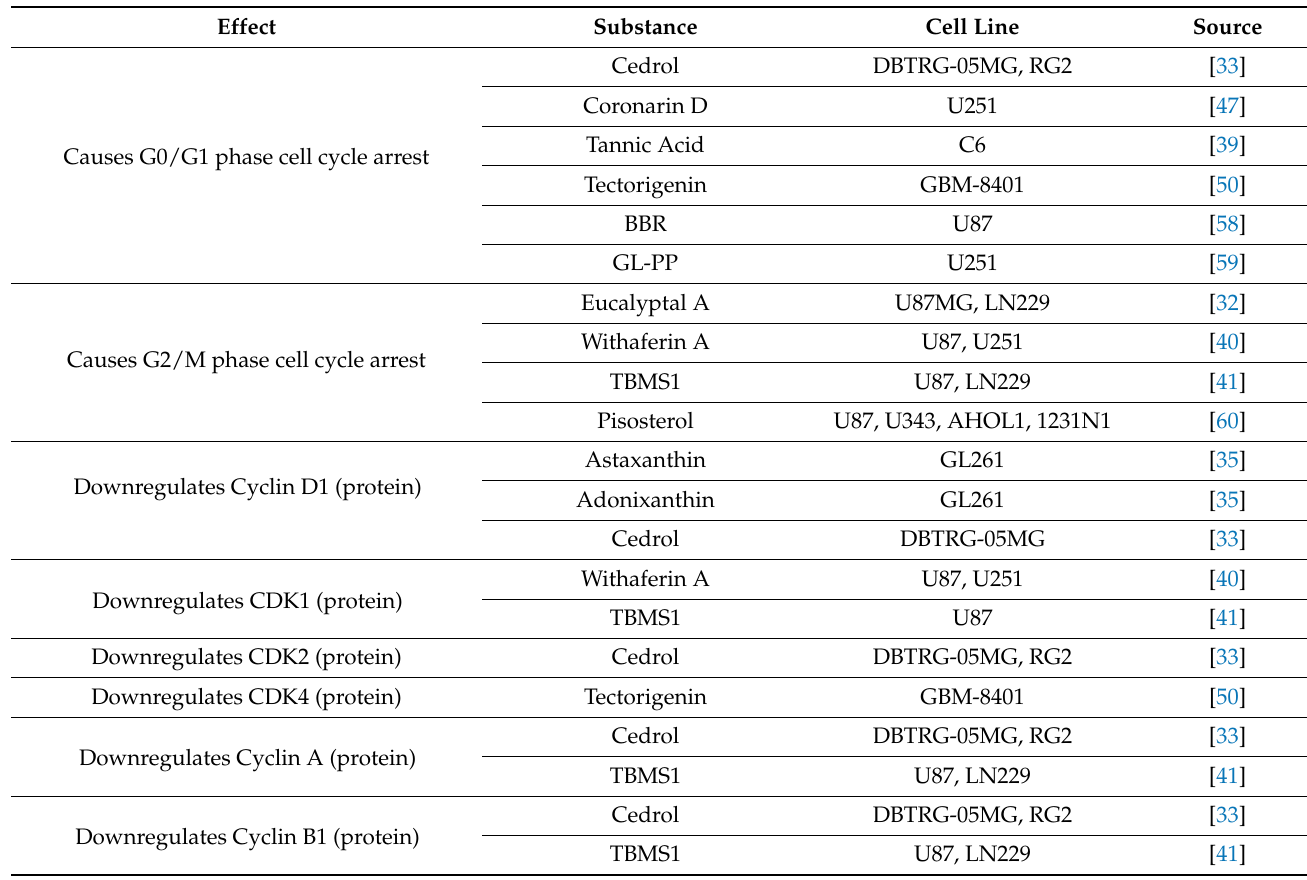
Figure 7. Inhibition of regulatory proteins allows for continuous cyclin/CDK activity and cell cycle progression in GBM cells. In healthy cells, FOXO and p53 can activate p27 and p21, respectively, and consequently induce cell cycle arrest to maintain homeostasis. DNA damage as a result of ROS accumulation is a key trigger for p21 activation. However, overactive Akt inhibits FOXO and p53, and therefore facilitates uncontrolled tumor cell growth and division. Table 6. Natural substances induce cell cycle arrest in GBM by upregulating p53, p21, and p27, and inhibiting several cyclins and their associated